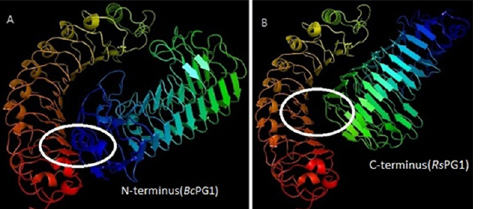
Fig 4. Docking studies of CkPGIP1 with polygalacturonase from Botrytis cinerea and Rhizoctonia solani . A-B. A concave site in CkPGIP1 interacts with the B1-sheet at the N-terminus of B . cinerea polygalacturonase ( A ), and with the C-terminus of R . solani polygalacturonase ( B ). When in complex with CkPGIP1, the substrate-binding site in the B . cinerea enzyme appears less exposed than in the enzyme from R . solani (circled in